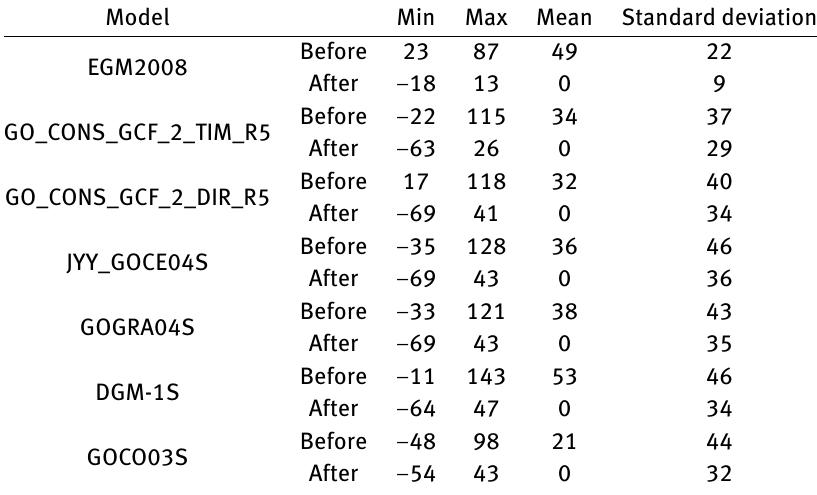
Table 3: Statistics of the differences between GGM geoid heights and GNSS/levelling geoid heights for 10 GNSS/levelling points over Uganda (Unit: cm)